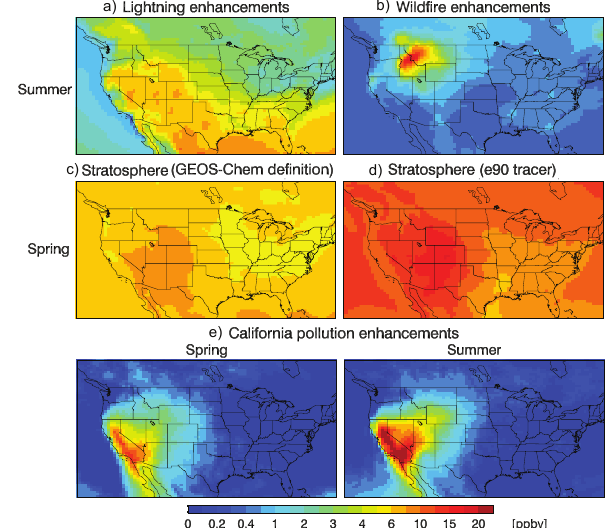
Figure 7. Effects of different sources on seasonal mean MDA8 surface ozone as simulated by GEOS-Chem. Top panels: enhance- ments from lightning and wildfires for summer (June–August) 2007, as diagnosed by difference with a simulation not includ- ing these sources. Middle panels: stratospheric influence in spring (March–May) 2006 estimated by defining stratospheric ozone either as ozone produced above the tropopause (Zhang et al., 2011; left) or ozone transported across the tropopause (Lin et al., 2012; right). Bottom panels: enhancements from California anthropogenic emis- sions for spring and summer 2006, as diagnosed by difference with a simulation not including these